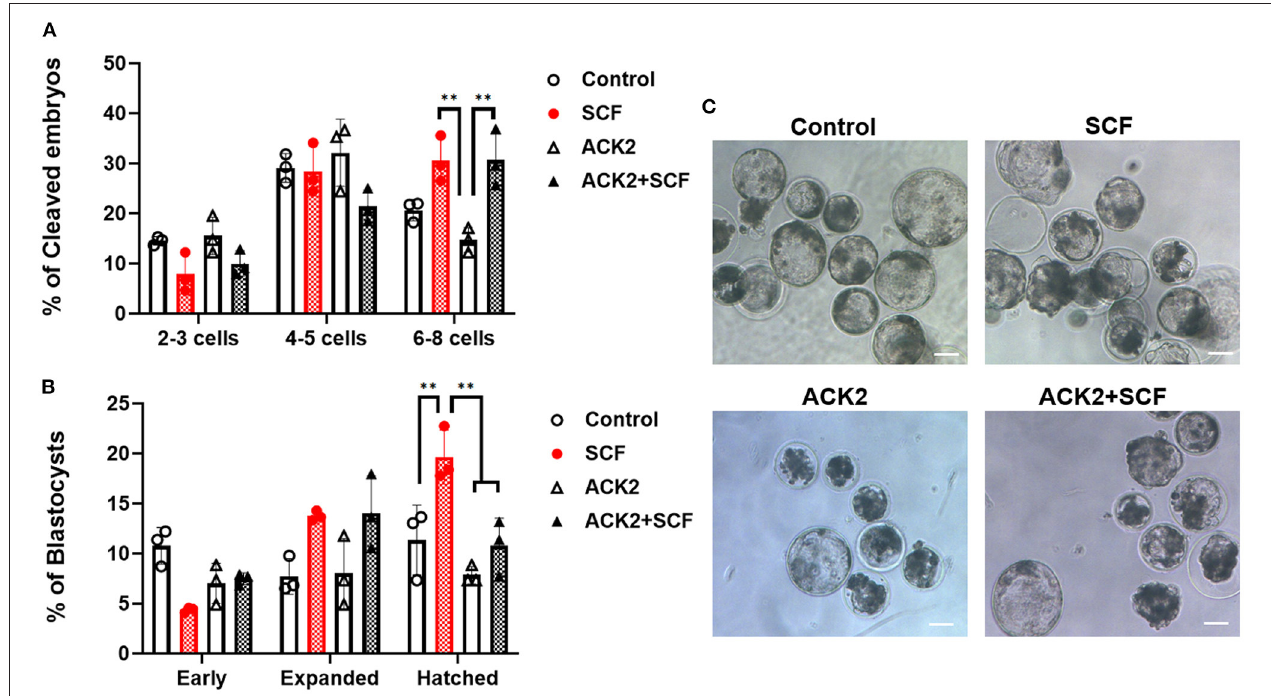
FIGURE 5 | Effect of stem cell factor (SCF)/c-kit signaling during porcine in vitro maturation (IVM) on the cleavage pattern of in vitro fertilized (IVF) embryos at day 2 (A) and the percentage of IVF embryos that developed to the blastocyst stage at day 7 (B) . For all graphs, the value represents the mean ± SEM. Asterisks indicate statistical significance (** p < 0.01). Statistical significance was determined by one-way ANOVA. The experiments were performed in triplicate. Early, early blastocyst; Expanded, expanded blastocyst; Hatched, hatched blastocyst. (C) Representative morphologies of porcine blastocysts from each group 7 days after IVF. Scale bar = 100 µ